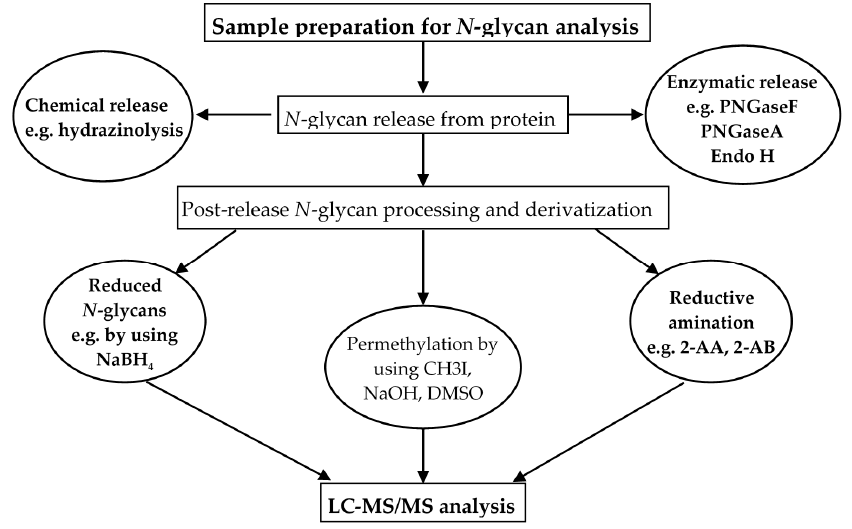
Figure 2. Sample preparation for N -glycan analysis by LC-MS/MS.